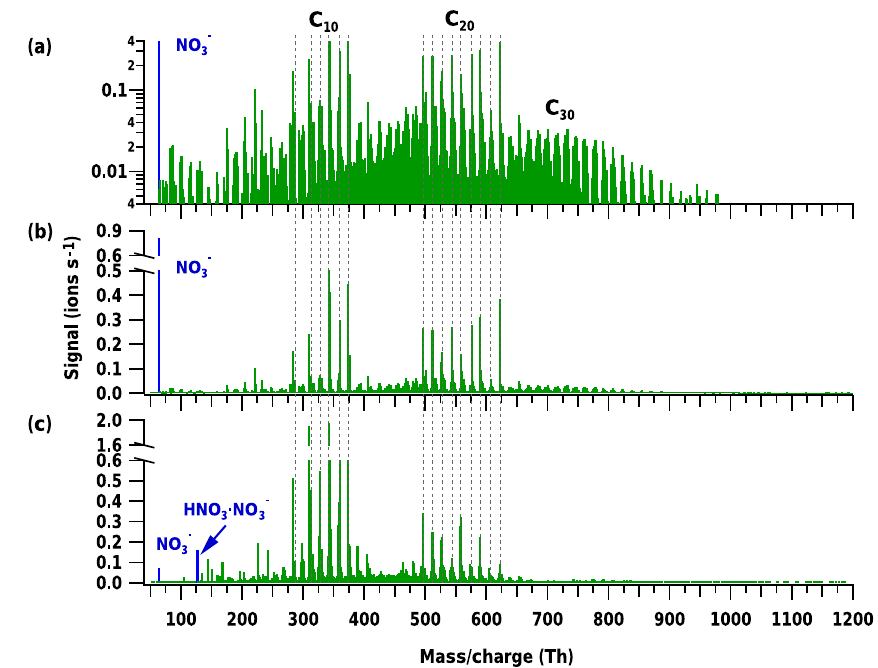
Figure 2. Comparison of the negative ion composition during α -pinene ozonolysis in CLOUD and during nighttime in the boreal forest at Hyytiälä (Finland). (a) CLOUD spectrum on a logarithmic scale. (b) CLOUD spectrum on a linear scale. (c) Typical nighttime spectrum from the boreal forest at Hyytiälä (Finland), adapted from Ehn et al. (2010).